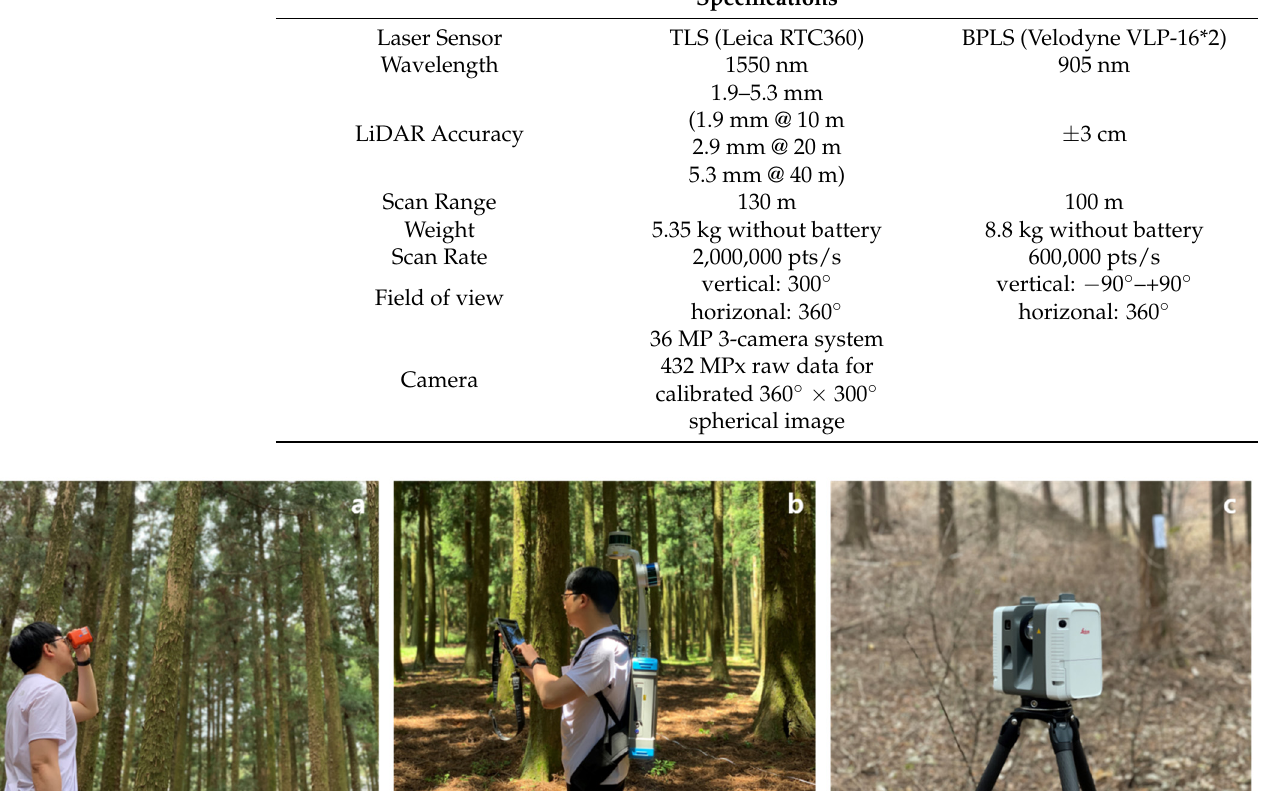
Table 2. Description of the TLS (RTC360) and the BPLS (LiBackpack D50).